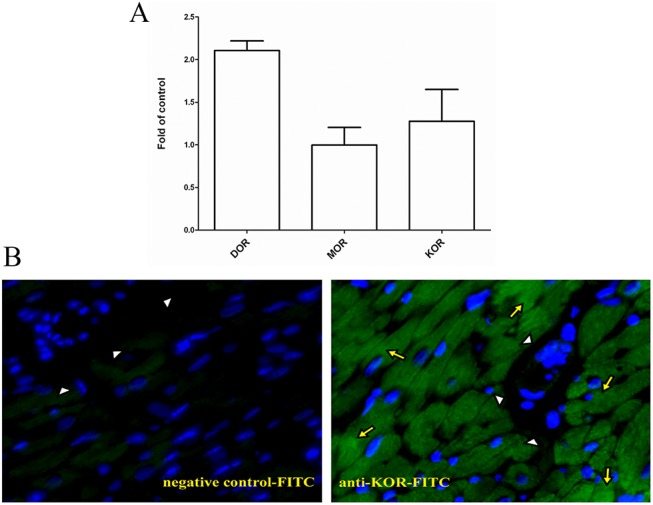
Molecular evidence of kappa opioid receptor (KOR) in rat heart.After rat hearts were harvested from the animals, total RNA was isolated and tissue specimen prepared for real-time PCR (A) and immunofluorecent staining (B) as described in Methods. The real-time PCR was analyzed using glyceraldehyde-3-phosphate dehydrogenase (G3PDH) as internal control and normalized using mu opioid receptor as relative baseline level. KOR, kappa opioid receptor; DOR, delta opioid receptor; MOR, mu opioid receptor. Yellow arrows indicate the localization of KOR in cardiomyotes while white arrow heads indicate the margin of a vessel. The results were repeated in three independent experiments, only represented figure was shown.